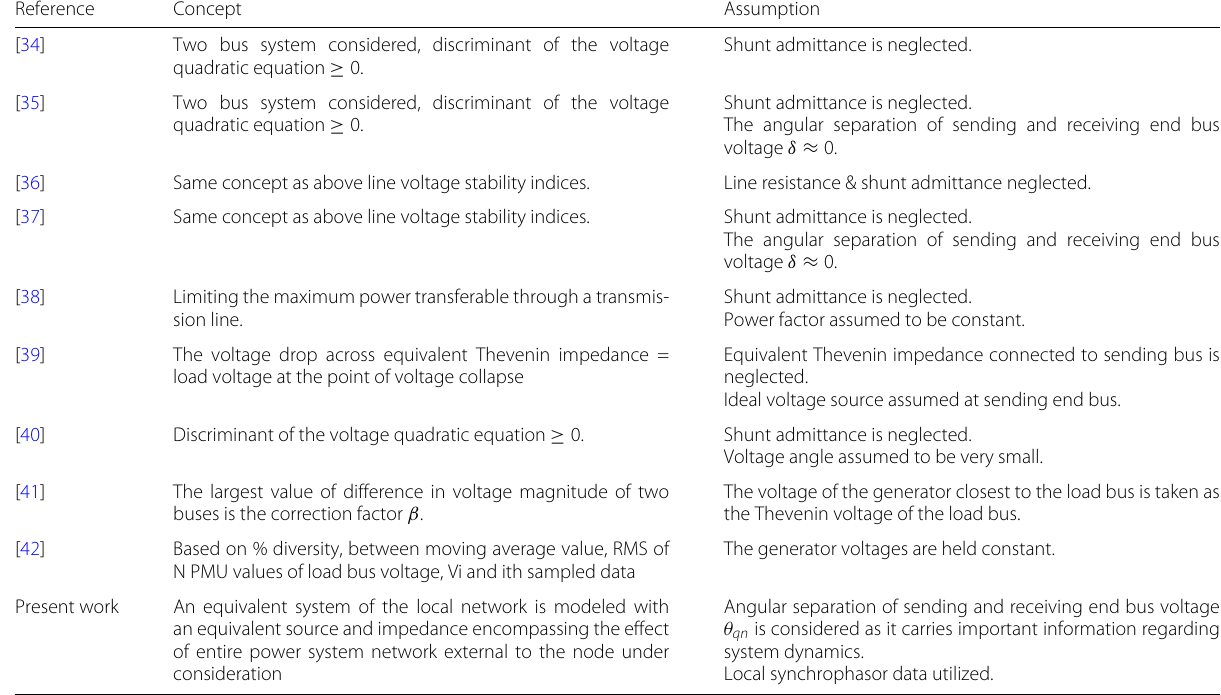
Table 1 A comparison of concepts on voltage stability